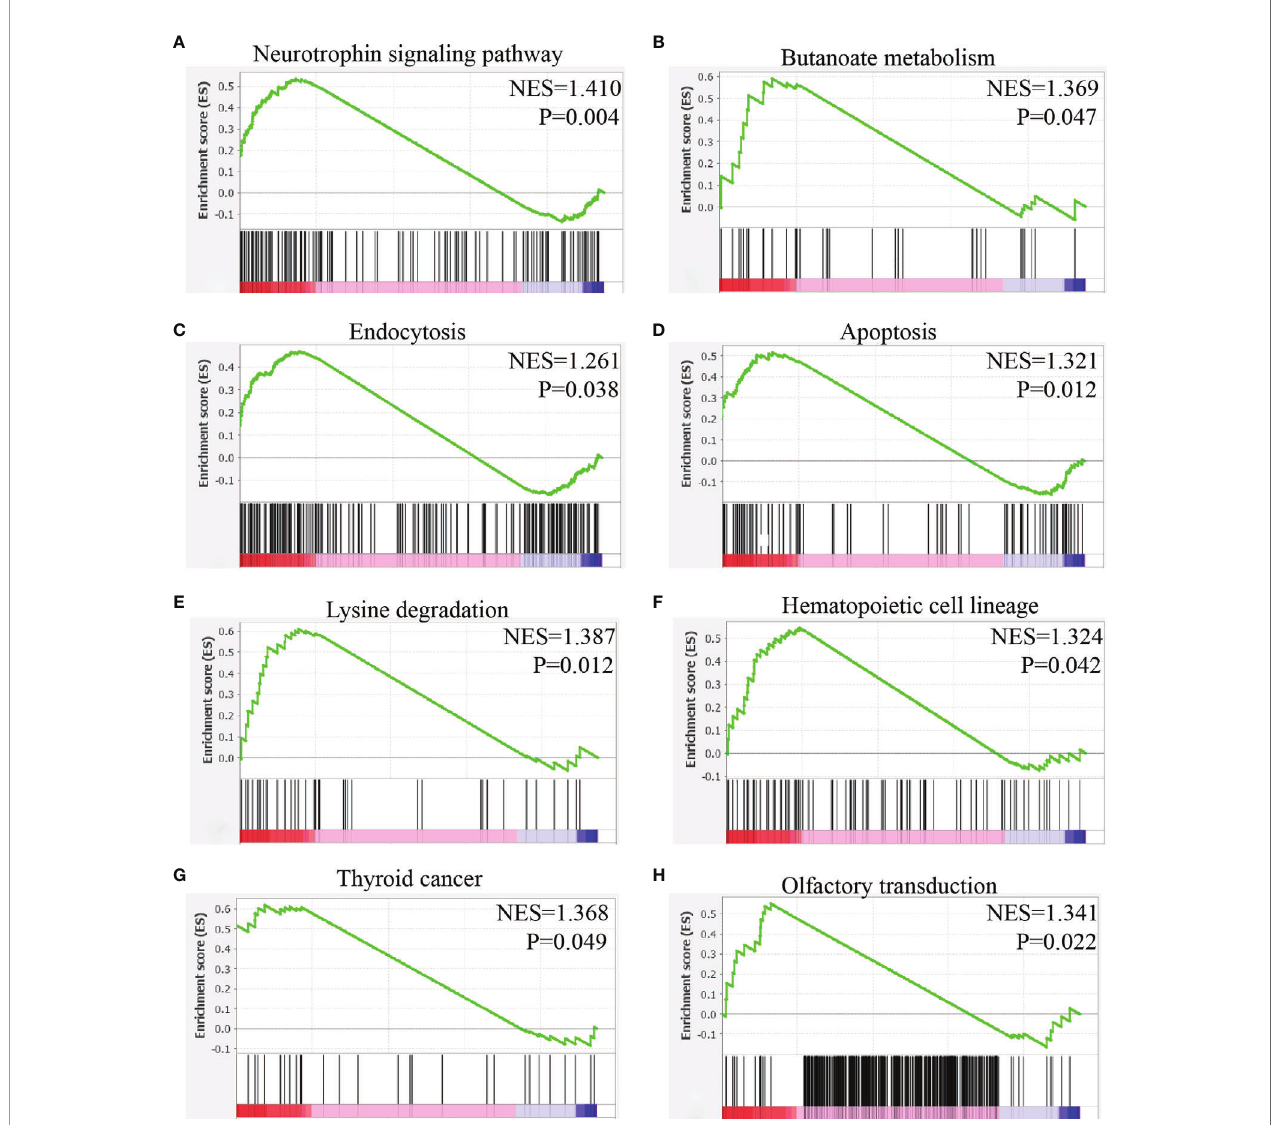
FIGURE 11 | Gene set enrichment analysis of NTRK1 in mast cells of HNSC. (A) The expression of NTRK1 positively correlated with the neurotrophin signaling pathway. (B) The expression of NTRK1 positively correlated with the butanoate metabolism. (C) The expression of NTRK1 positively correlated with the endocytosis. (D) The expression of NTRK1 positively correlated with the apoptosis. (E) The expression of NTRK1 positively correlated with the lysine degradation. (F) The expression of NTRK1 positively correlated with the hematopoietic cell lineage. (G) The expression of NTRK1 positively correlated with the thyroid cancer. (H) The expression of NTRK1 positively correlated with the olfactory